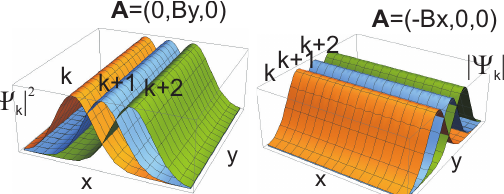
Figure 4. Pictorial presentation of k striping of electrons and holes in opposite layers. Charge density of the electron, according to wave functions given by Equation (10) for k state, is exactly the same as of the hole in − k state. To allow exciton formation, the consecutive states k , k + 1, k + 2, . . . ordered as represented by their density, | Ψ k | 2 , in the figure in compliance with Equation (10) must by aligned perfectly in front of oppositely ordered states of holes, − k , − k − 1, − k − 2, . . . .